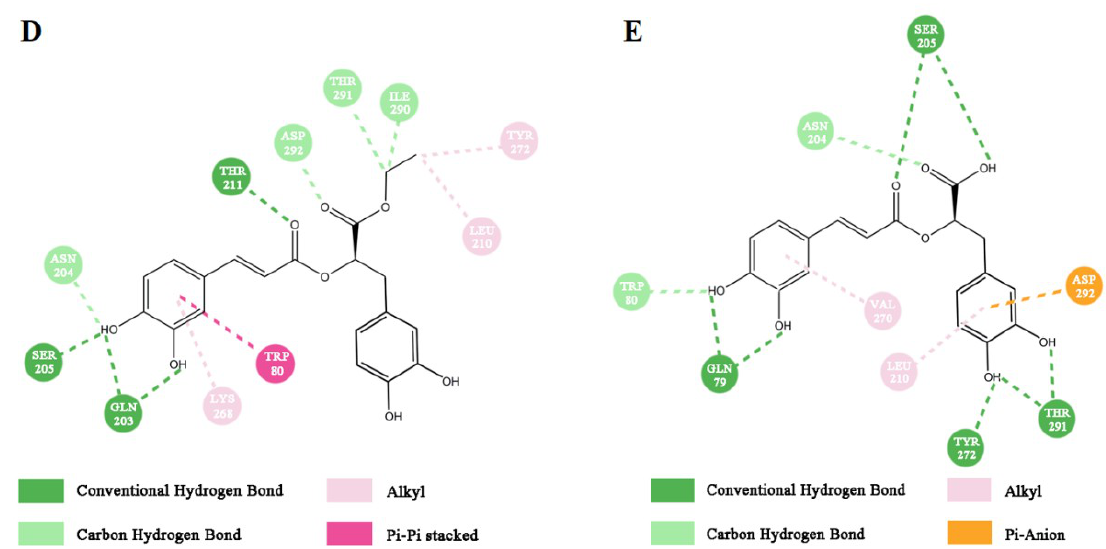
Figure 4. ( A ) Effect of RAE on Akt phosphorylation in endothelial cells treated with high glucose. EA.hy926 cells were treated with RAE or RA in the medium containing 33 mM of glucose for 48 h. Cells were exposed to LY294002 for 30 minutes before incubation with high glucose and RAE. Then, the cell lysates were collected. The phosphorylation of Akt was detected by Western blot using a phosphor-specific Akt antibody, normalized to total Akt. The results were expressed as mean ± SD (n = 5), and one representative image of five individual experiments is shown. ## P < 0.01, vs. control; * P < 0.05, ** P < 0.01, vs. high glucose; & P < 0.05, && P < 0.01, vs. RAE (10 µM) group. ( B ) Docked pose of RAE in the active site of Akt. ( C ) Docked pose of RA in the active site of Akt. ( D ) Docking interactions of RAE with proper residues in the active site of Akt. ( E ) Docking interactions of RA with proper residues in the active site of Akt.